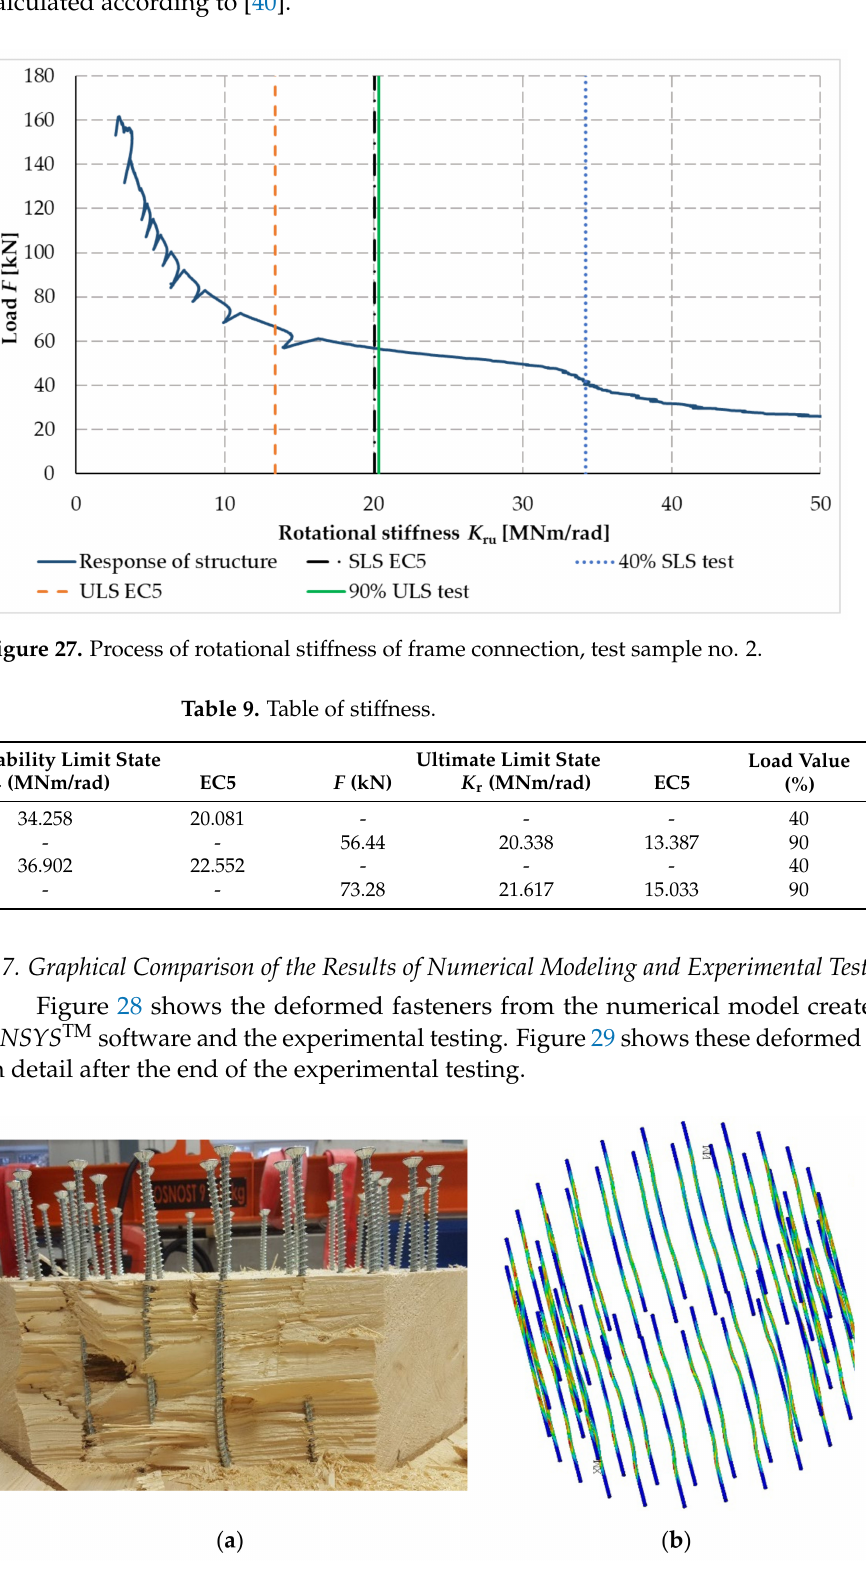
Figure 28. ( a ) Deformed fasteners after experimental testing. ( b ) Deformed fasteners in numerical model ANSYS TM